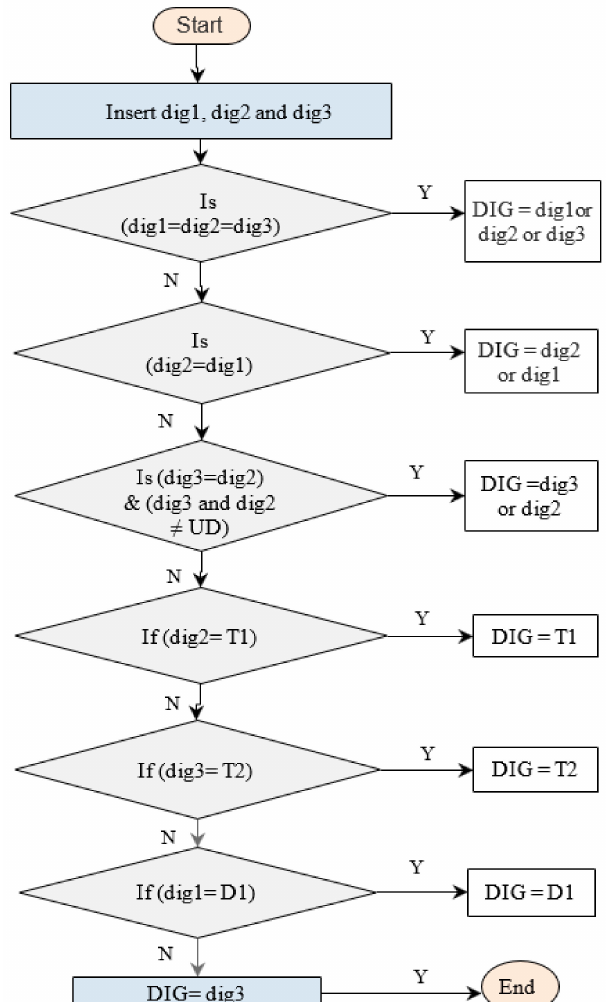
Figure 2. Flowchart procedure of technique no.